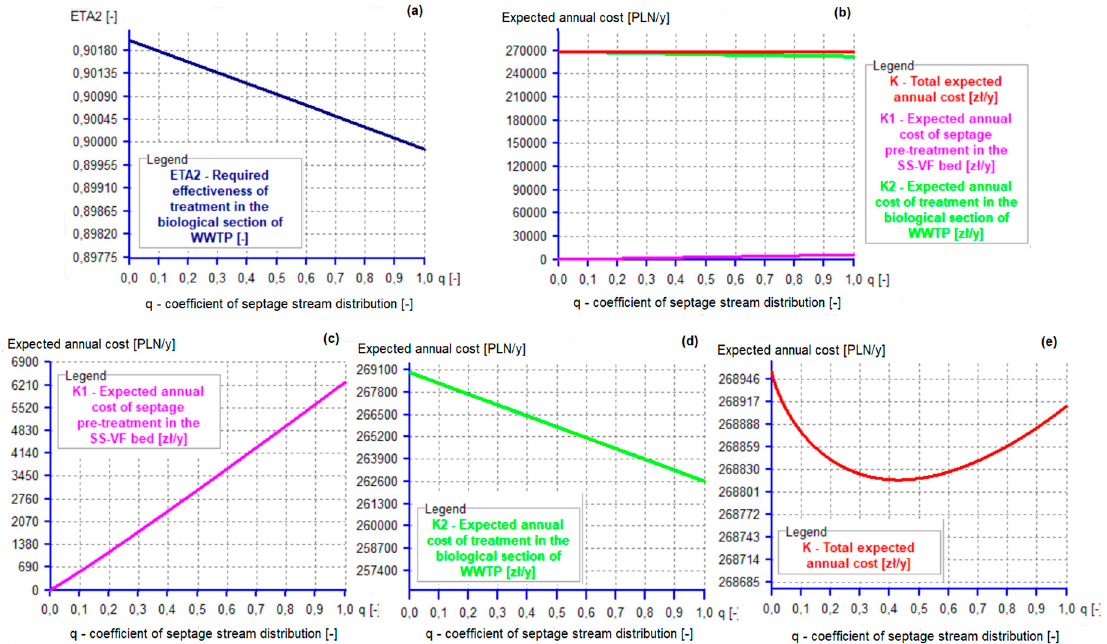
Figure 10. Example 3—summary of the dependence of decision variable on: required effectiveness of treatment in biological stage of WWTP ( a ) and costs K 1 , K 2 , K ( b ), cost K 1 ( c ), cost K 2 ( d ) and cost K ( e ).